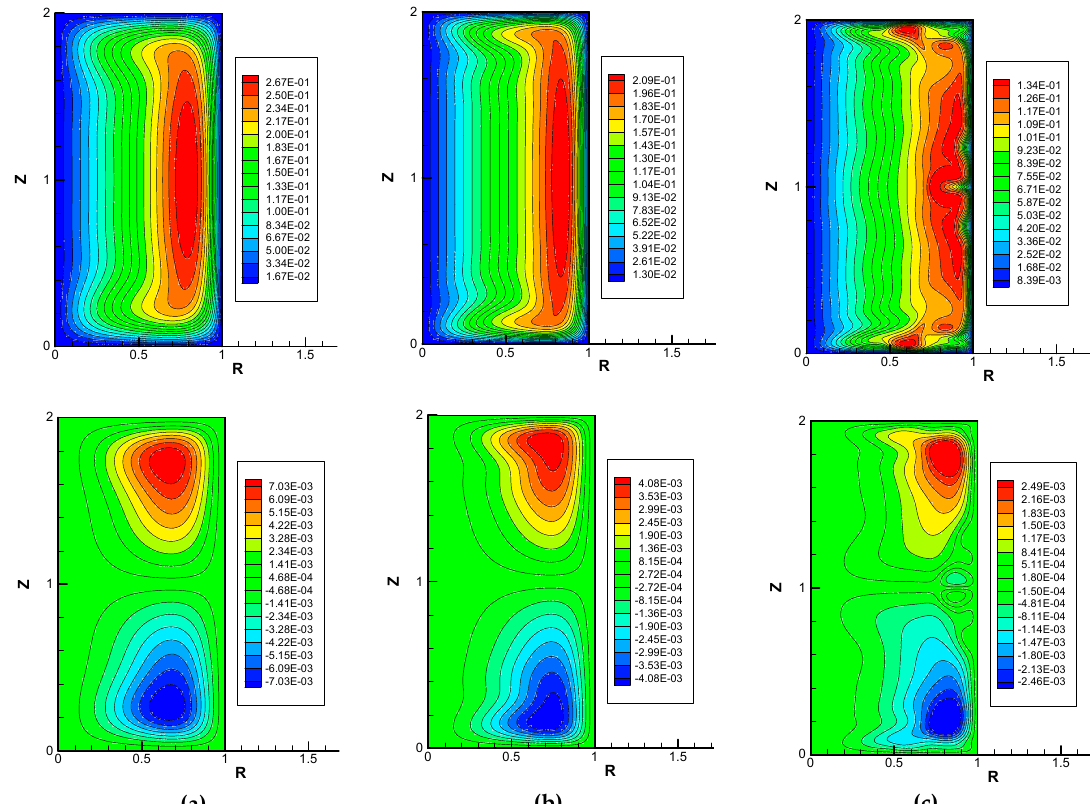
Figure 11. Contour maps of the azimuthal velocity (upper) and Stokes stream function (lower) for the three values of Reynolds number at m = 1 and Ha = 8. The maps in ( a ) Re = 500 and ( b ) Re = 2000 indicate steady flow while that in ( c ) Re = 10000 indicates an instantaneous snapshot because of the unsteady flow.